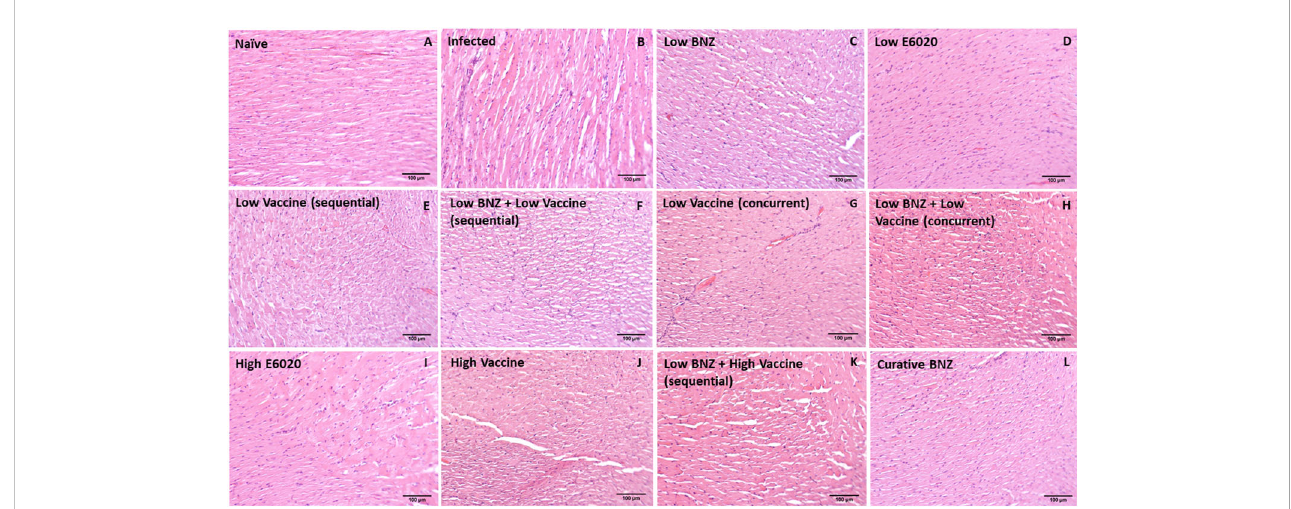
FIGURE 10 Representative images of H&E stained cardiac tissue sections from naïve (A) , infected untreated (B) and treated (C – L) mice. Images were captured at 100X magni fi cation. Scale bar represents